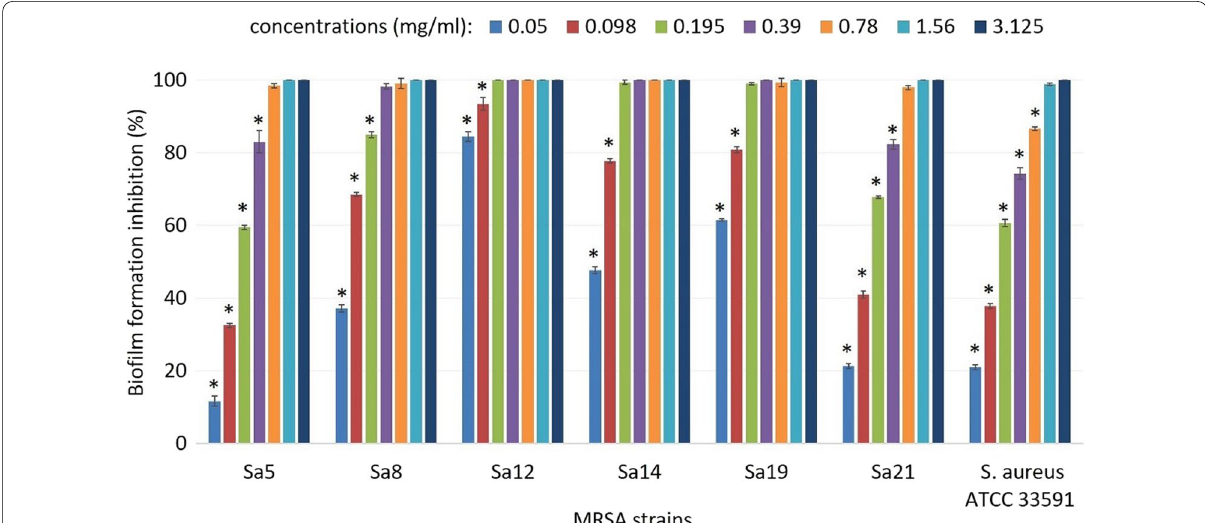
Fig. 1 The presence of the biofilm formation inhibition regard to strains Sa5, Sa8, Sa12, Sa14, Sa19, Sa21 and S. aureus ATCC 33591. Error bars represent standard deviations (SD). * P <